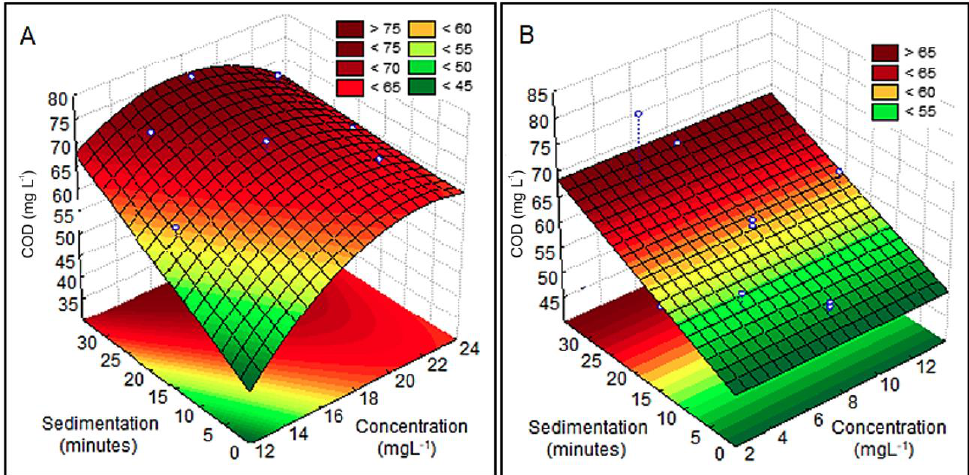
Figure 7. Surface graphics of COD treatment using magnetite associated with ( A ) tannin and ( B ) Moringa oleifera .